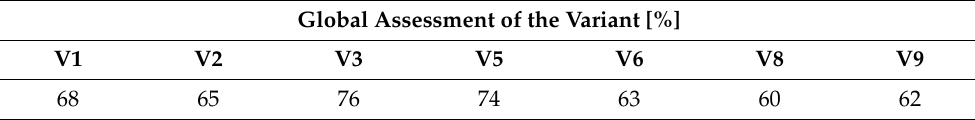
Table 6. Global assessment of the variant obtained using the compensation-conjunctive method.